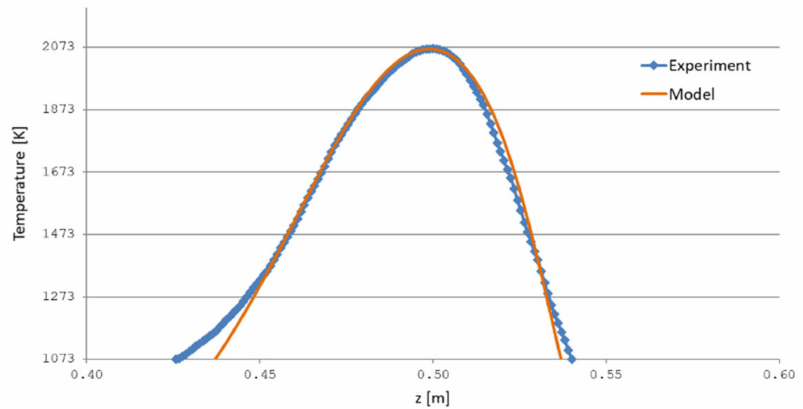
Figure 13. Comparison of the results of numerical simulation and experiment with a moving heat source. v ( t ) = 70 (mm/min); Q H2 = 31.5 [l].